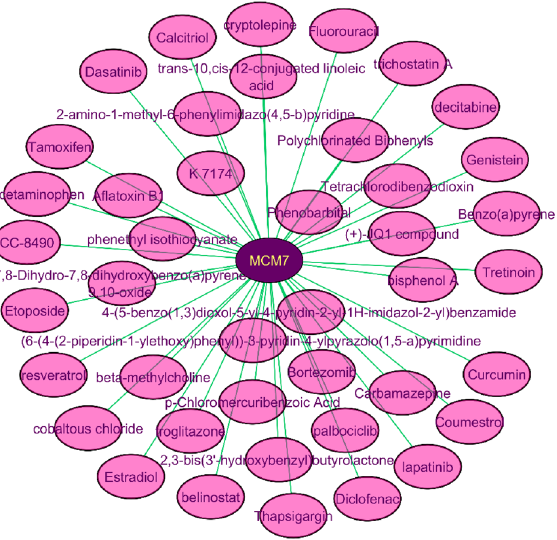
Figure 1. The protein–drugs interaction network of MCM7, where purple color represents the MCM7 protein and pink color represents the drugs.